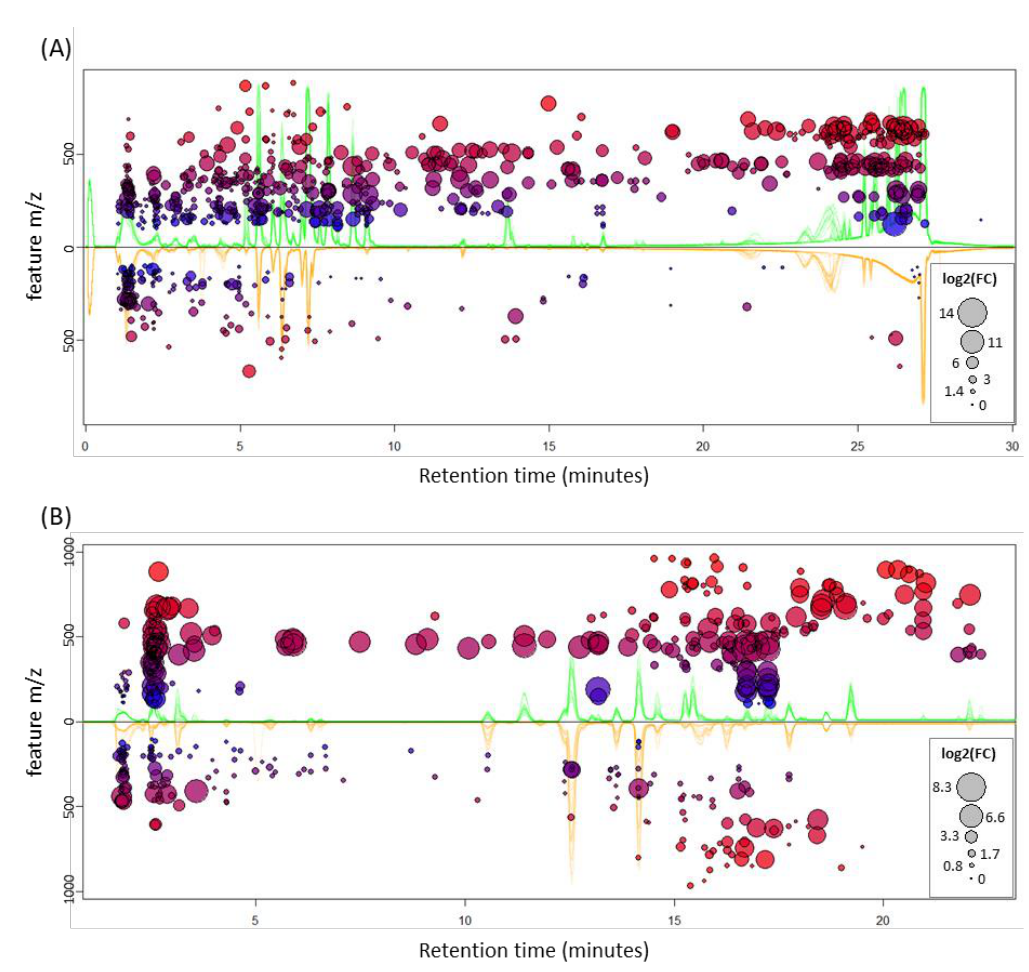
Figure 4. Mirror plots of differentially accumulated features (DAFs). DAFs (FDR < 0.01) in polar ( A ) and non-polar ( B ) extracts are shown for leaf (top) and pitcher (bottom). Circle size depicts the absolute value of the log 2 of the average fold change, on the top if it is over-accumulated in leaf, and on the bottom otherwise. Color and y-axis value depict the m / z value of the feature, with blue being low- (100) and red high- (1000) m / z features; the further away from the origin, the higher the m / z , as indicated by the y-axis. The superimposed, raw base-peak chromatograms (BPC) of all runs are shown in the background, colored accordingly: green, all leaf BPCs; orange, all pitcher BPCs.